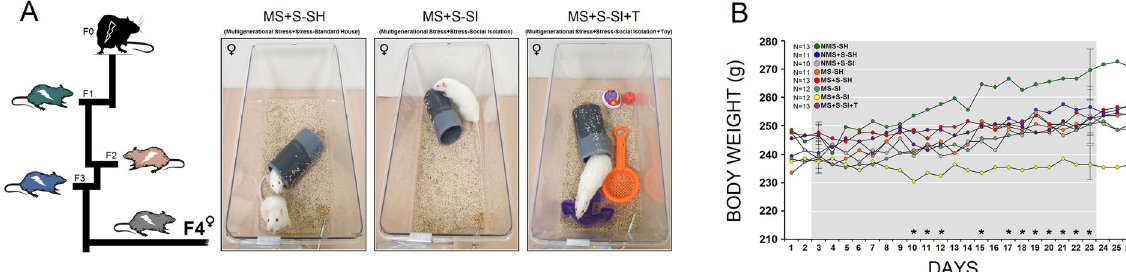
Figure 1. ( A ) Experimental design to induce multigenerational and adulthood stress in F4 females . Left: Animals of the parental generation (generation 0; F0) and their prenatally stressed pregnant daughters (filial generations 1–3; F1-F3) also received stress during late gestation. Right: the F4 generation that originated from a stressed maternal lineage received a stress challenge in adulthood while housed in standard paired housing conditions (MS + S-SH), socially secluded by singular housing (MS + S-SI), or received environmental enrichment with toys while being housed alone (MS + S-SI + T). ( B ) Stress and social isolation limit weight gain in ancestrally stressed rats . Grey-square zone indicates the 21-day stress period. Only MS + S-SI and MS + S-SI + T groups failed to gain weight during stress. A significant difference was observed between NMS-SH and MS + S-SI groups on the last day of stress exposure. Asterisks indicate significant difference between NMS + S-SI and MS + S-SI groups: * p ≤ 0.05. Error bars show ±